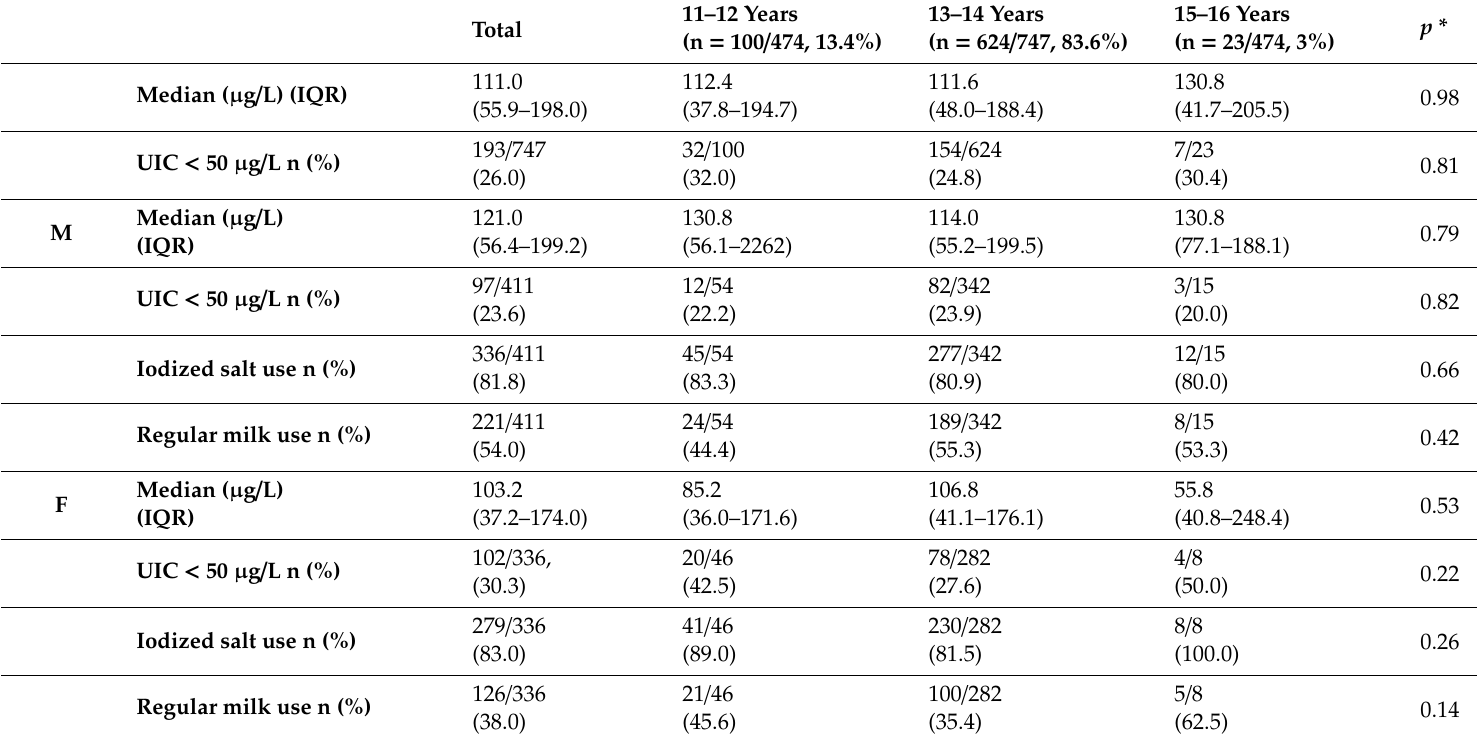
Table 1. Median urinary iodine concentration (UIC) ( µ g / L) and % of pupils with a UIC < 100 µ g / L, iodized salt use and regular milk consumption (daily or more) according to sex and age